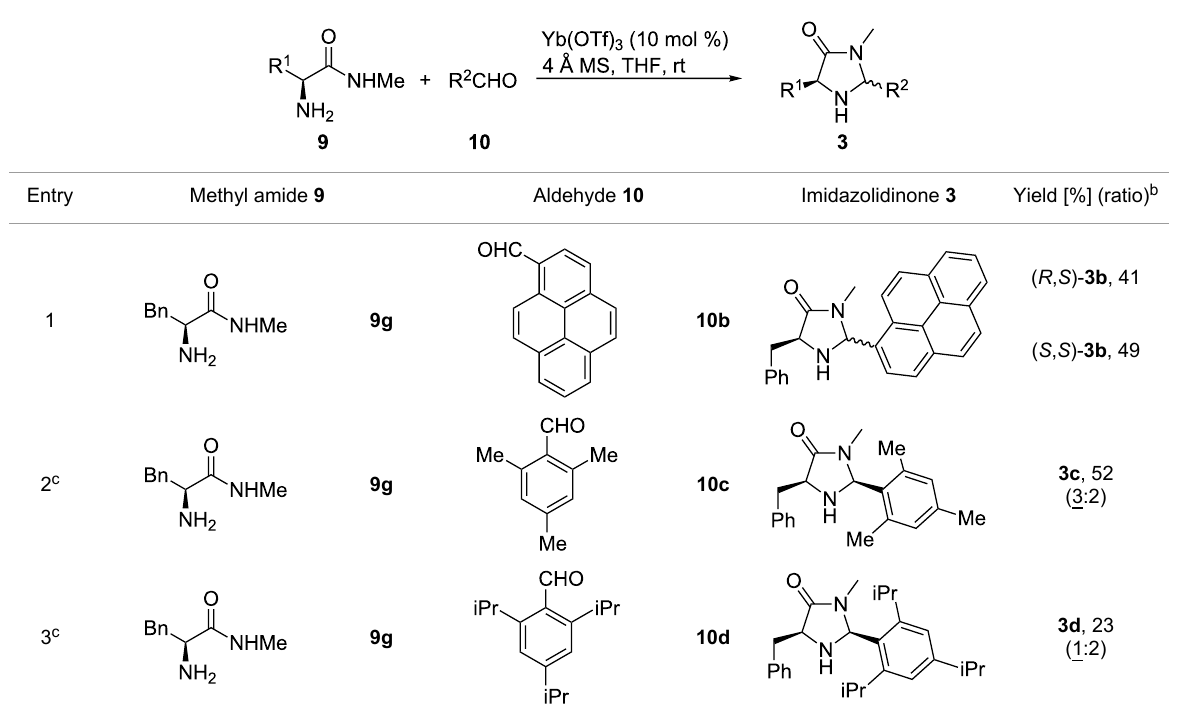
Table 2: Scope of the imidazolidinone formation with respect to aldehyde 10 .